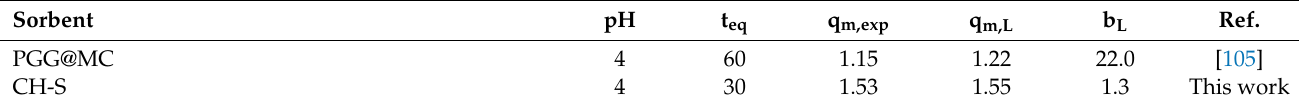
Figure 10. Desorption kinetics of uranium on CH ‐ S sorbent. From Table 7 shows stability of sorption and desorption recycling which shows a remarkable stability in both sorption (with limited decreasing; around 3% after five cycles) and the desorption efficiency which remains stable (higher than 99.5%). This means that, the prepared composite is shown a remarkably stable of reuses. Table 7. Sorption and desorption recycling for the sorbent toward uranium (VI) ions . Sorption